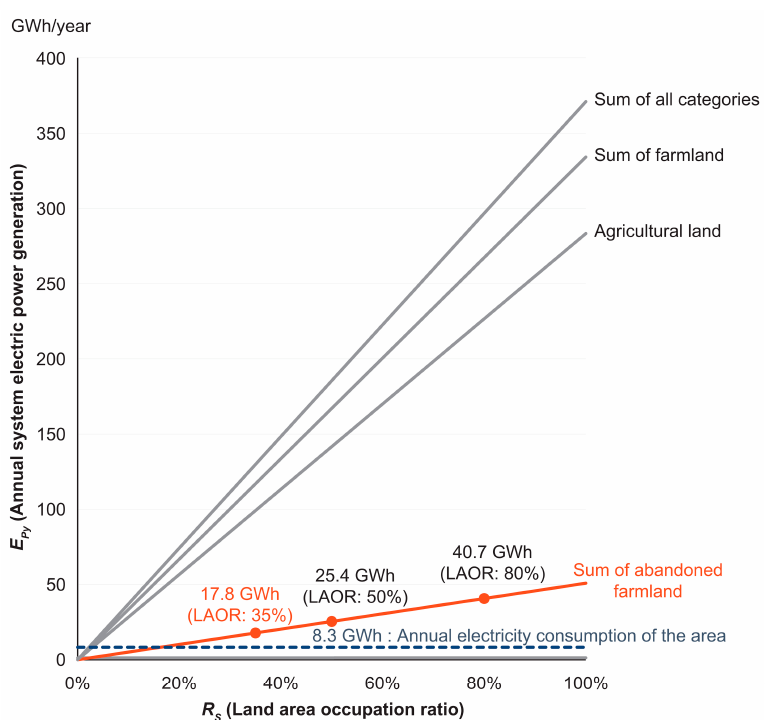
Figure 6. Estimated annual power generation from AVSs installed on abandoned agricultural land in Ine.